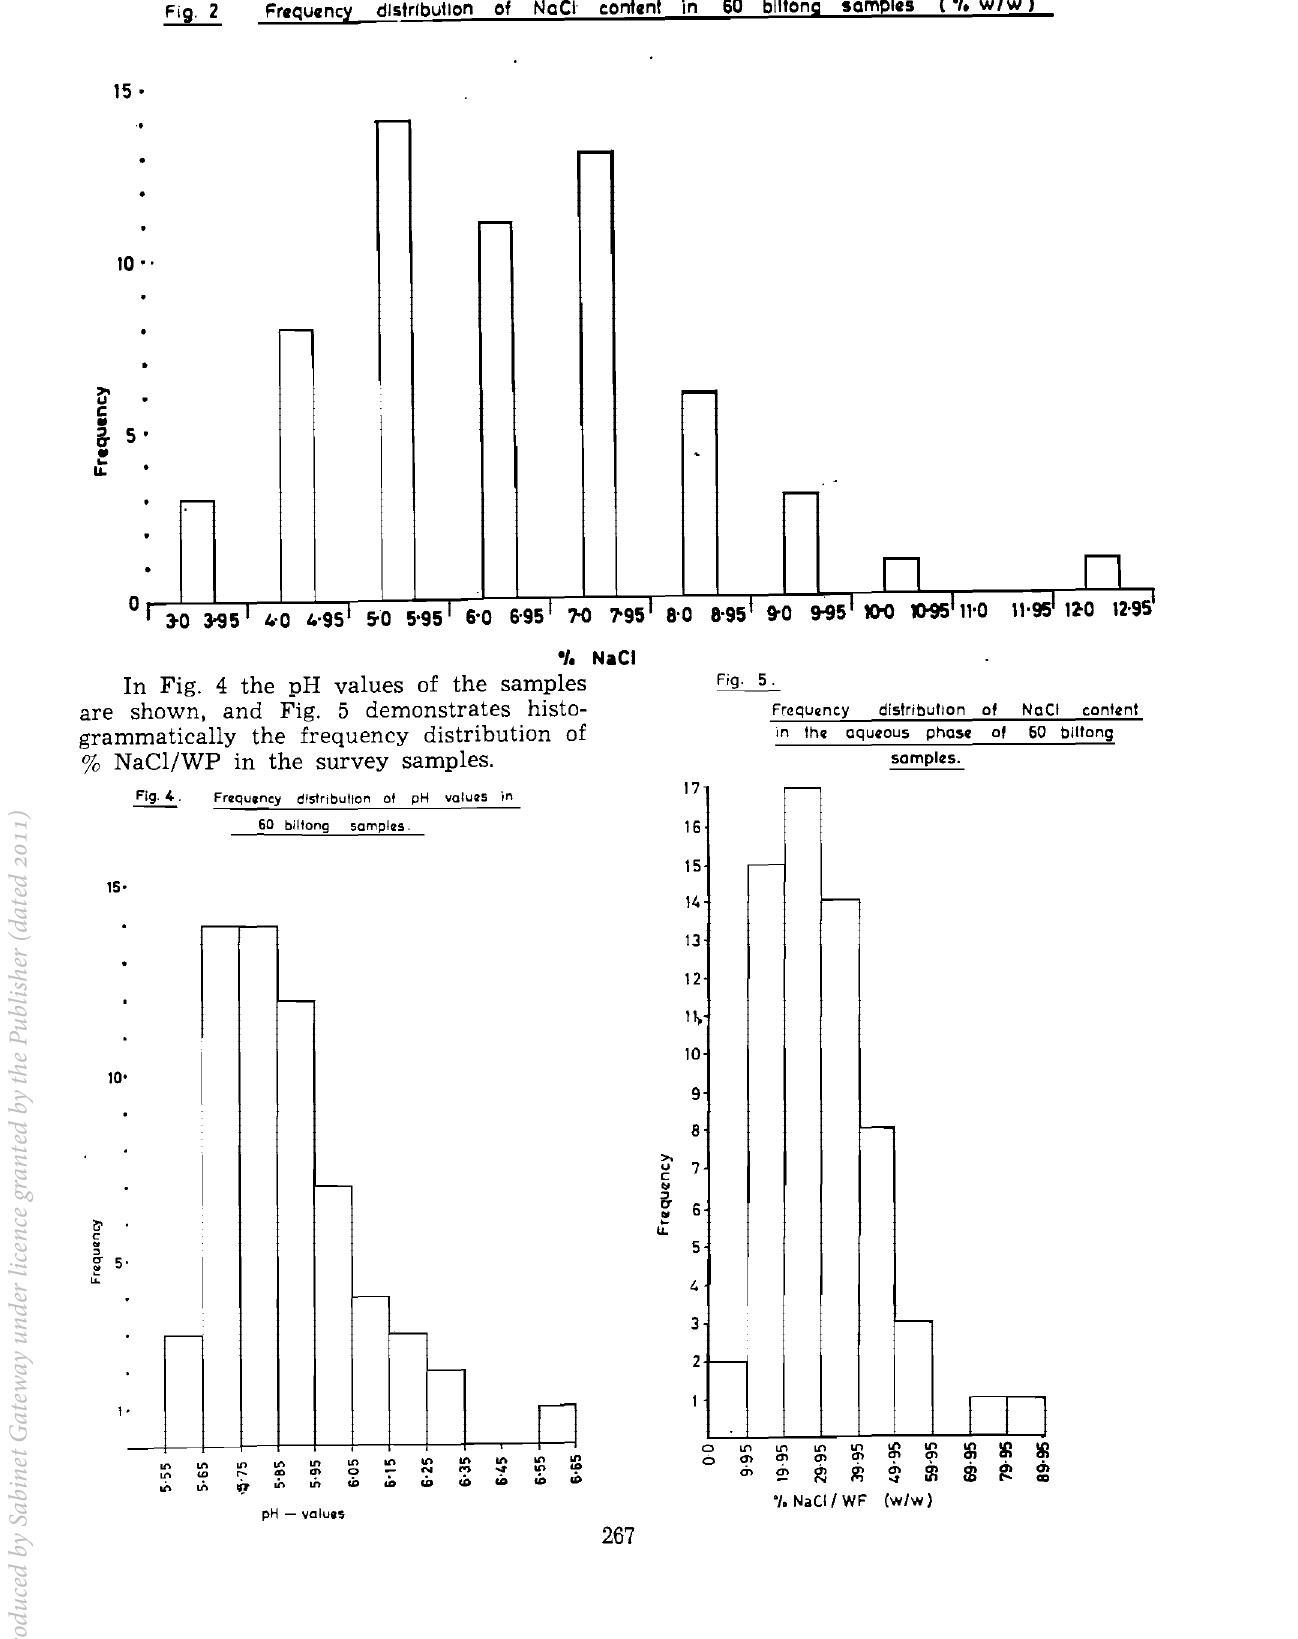
~ Frequency distribution 01 Noel content in the aqueous phase 01 60 biltong